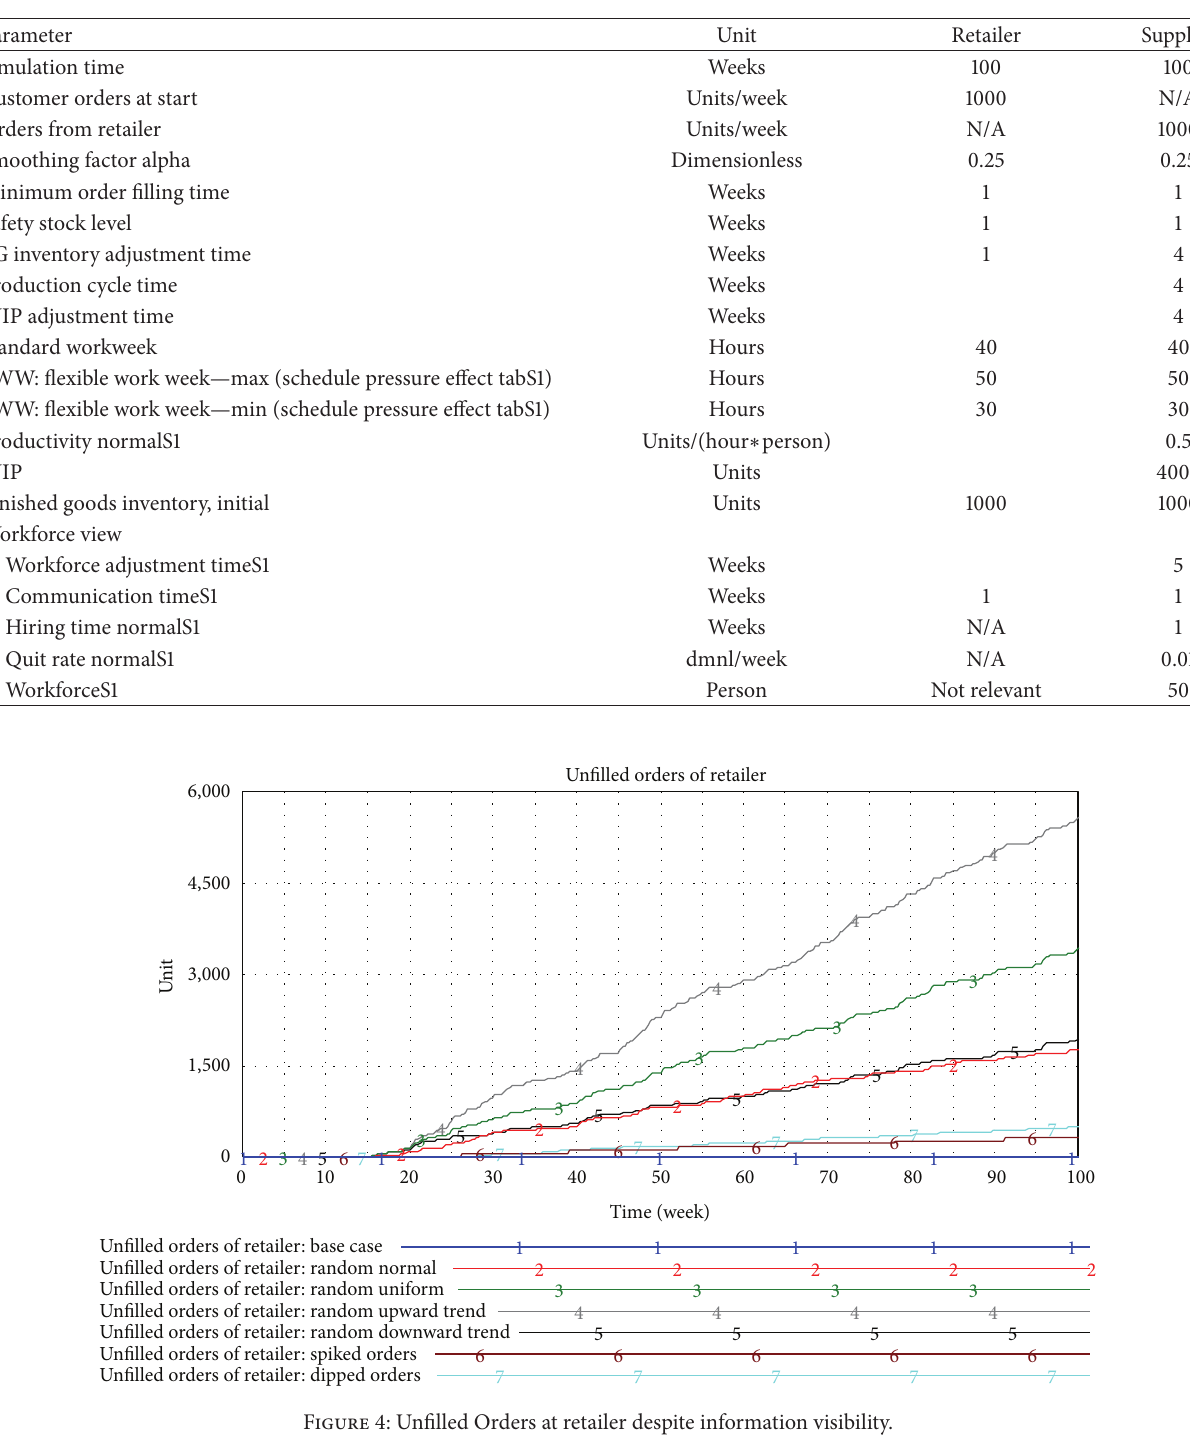
Table 1: Initial parameter settings.